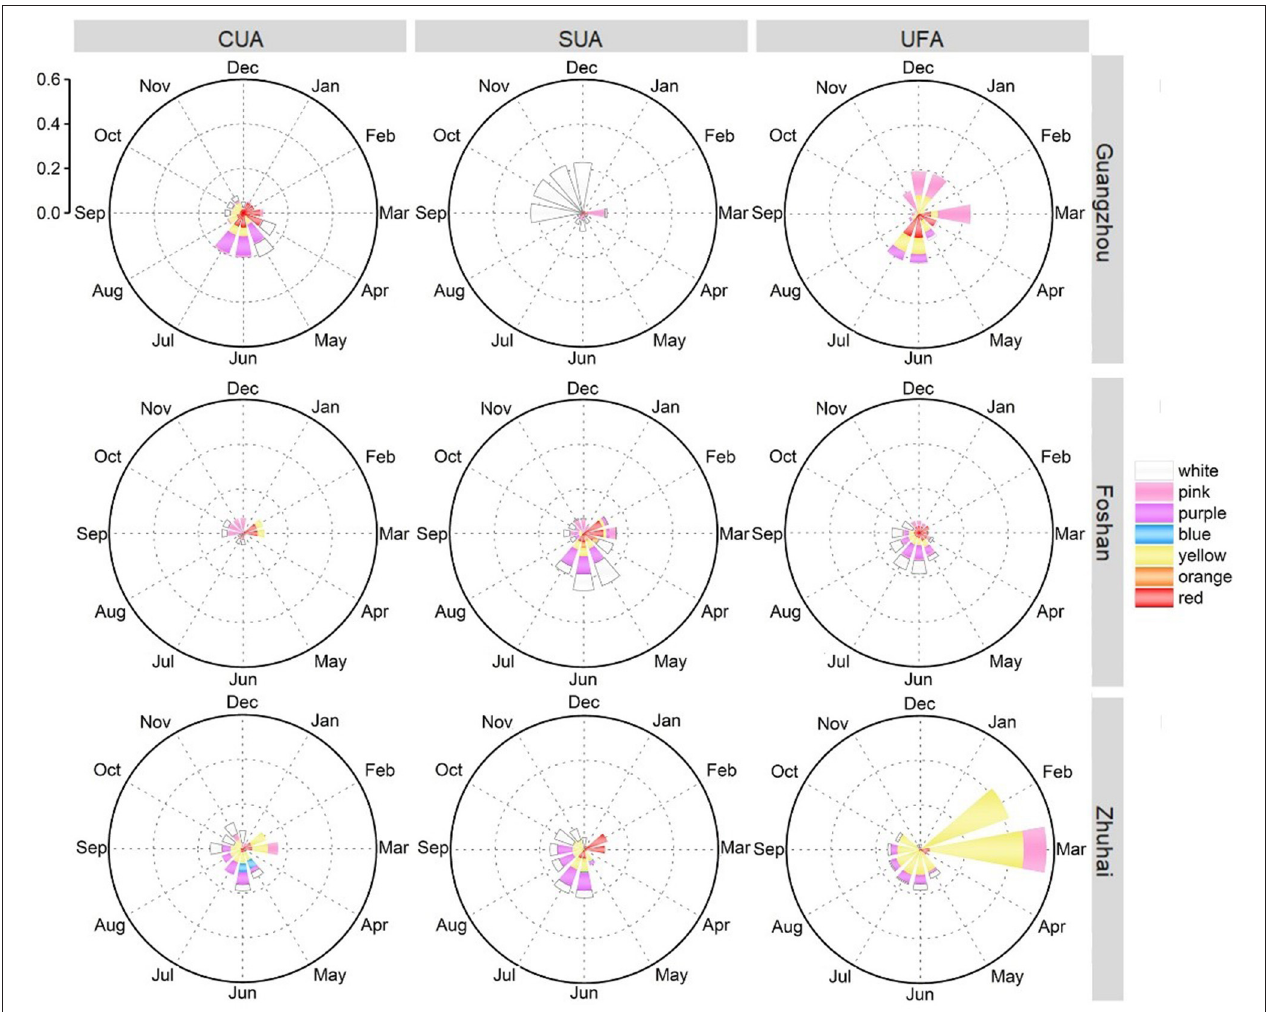
FIGURE 4 | Monthly statistics of the percentages of blossomed trees in CUA, SUA, and UFA of Guangzhou, Foshan, and Zhuhai. In each plot, the outer circle-axis represents 12 months in 1 year, and sectorial bars are the proportions of blossomed trees with their flowers’